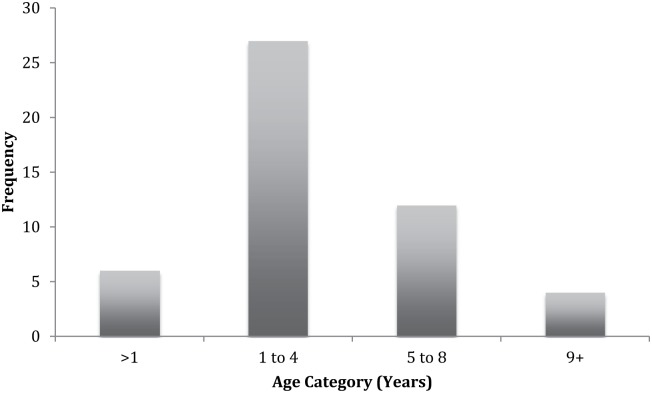
Frequency distribution of dog ages in communities of the Northern Peninsular Area (NPA), Australia.Most dogs were between 1 and 4 years of age. The maximum age was 10 years old. Twenty-five dogs were of unknown age. The 31 participants owned a total of 74 dogs (average 2.39 dogs per household). The range of dogs owned was 1–5 dogs per house.